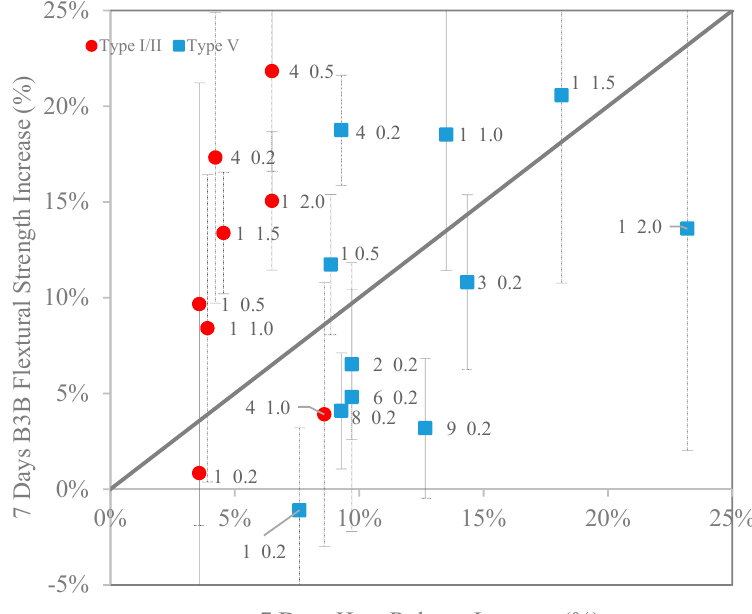
Figure 8. Comparison between B3B flexural strength and heat release increase (%). The label next to data denotes CNC type (number) and dosage (percentage) (note: for B3B flexural strength, the COV of the Type I/II control is 3.9%, and the COV of the Type V control is 3.0%).